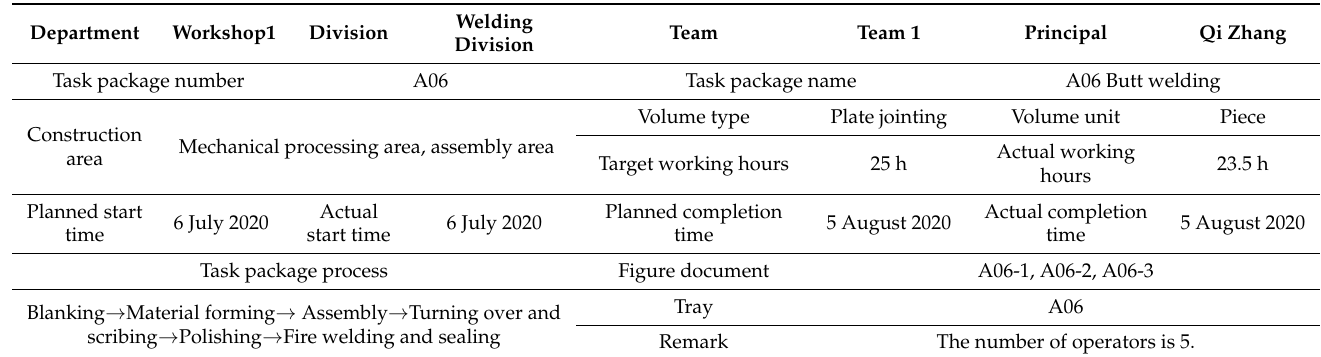
Table 2. The information structure of the task